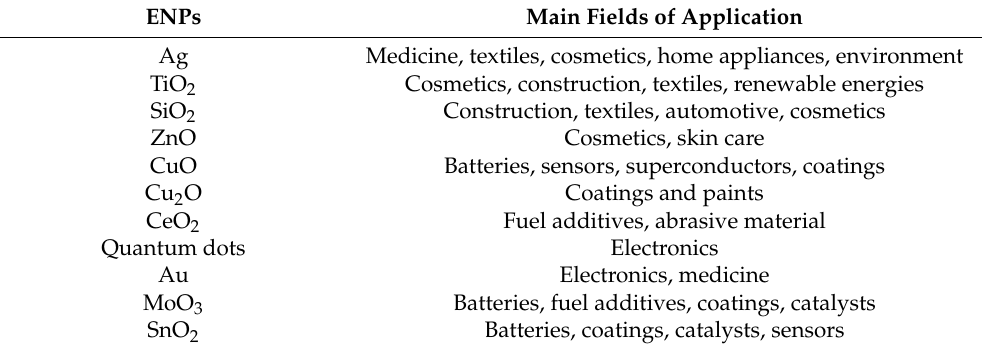
Table 1. Major types and modern uses of ENPs a . ENPs Main Fields of